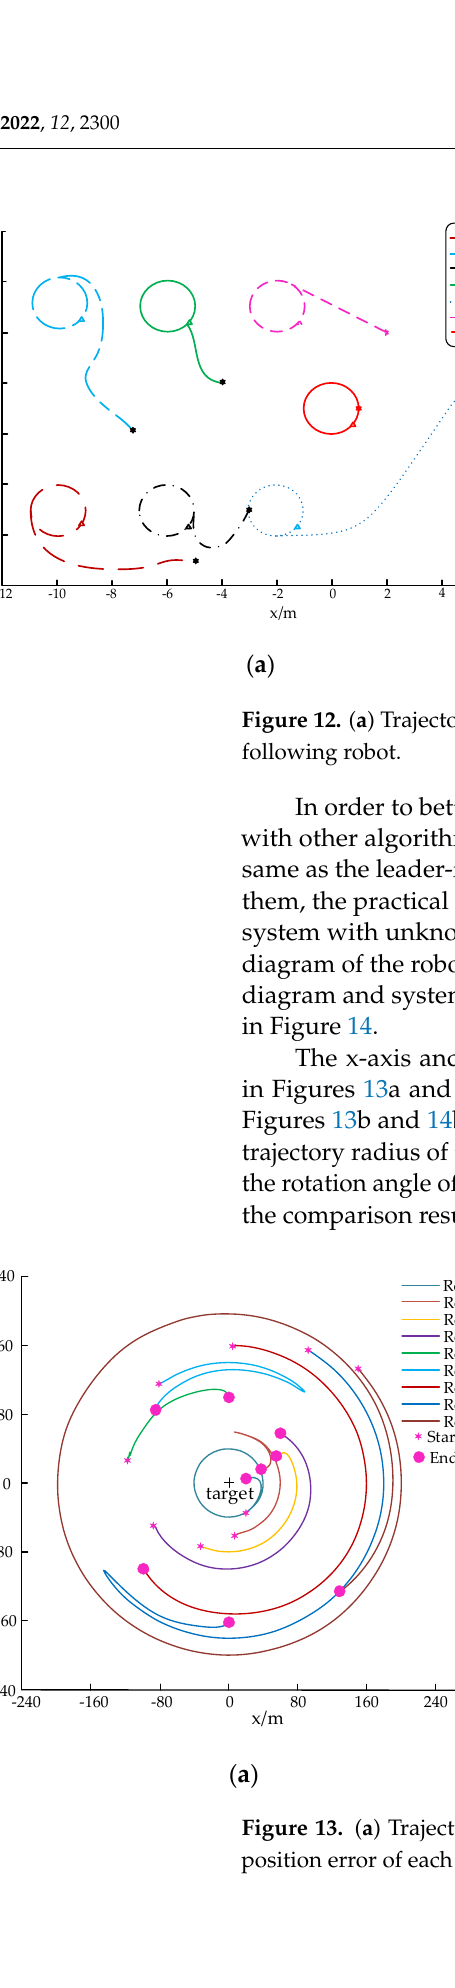
( b ) Figure 14. ( a ) Trajectories of ten robots on the plane by GCF in spiral formation; ( b ) Formation po- sition error of each following robot. The x-axis and y-axis are the coordinate changes during the motion of each robot in Figures 13a and 14a. The curves of formation position error over time are shown in Figures 13b and 14b. The horizontal axis represents time. In Figure 13b, r represents the trajectory radius of the robot centered on the point ‘target’ as the vertical axis. α represents the rota- tion angle of the robot in motion as the vertical axis. According to Figures 13 and 14, the comparison results are shown in Table 1 for forming spiral formation. To sum up, according to Figures 8–10, the simulation results show that the multi- mobile robots using the algorithm control law in this article can dynamically form for- mation during operation on the different formation problems. Through the comparison of the two algorithms in Table 1, it can be seen that the convergence time of the algorithm in this article will be 25% less than that of PFC. Compared with PFC, the number of robots is poor. However, the overall comparison of the formation control algorithm in this article is acceptable in theoretical analysis and simulation. Therefore, the formation control algo- rithm proposed in this article has effectiveness and feasibility.